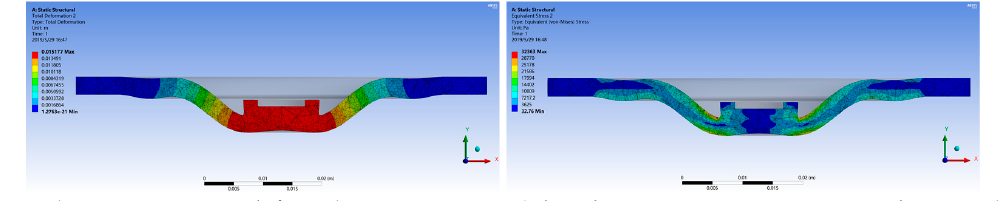
Figure 4. Diaphragm Deformation under Different Loading Area.